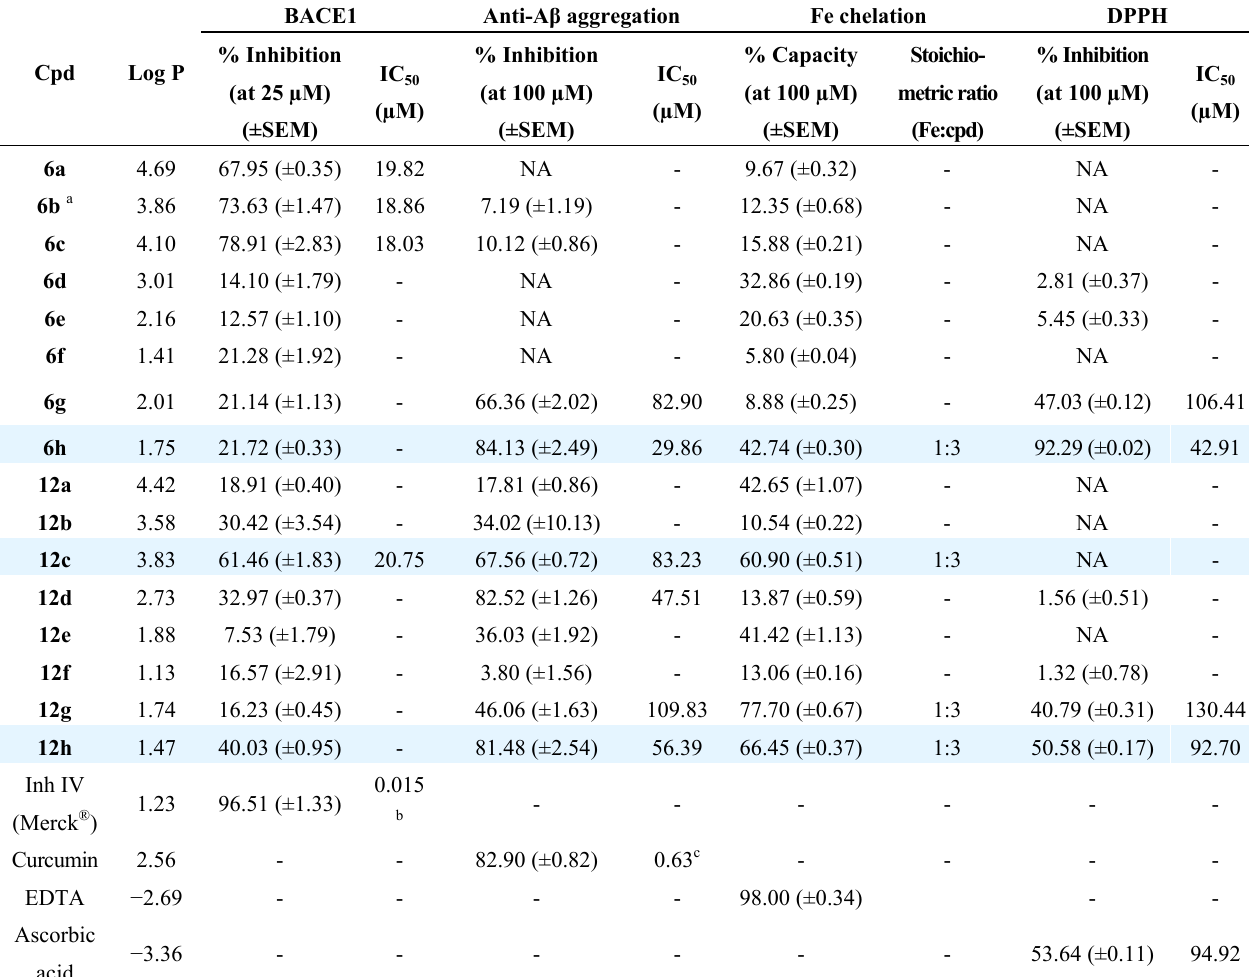
Table 1. Multifunctionality of triazole based